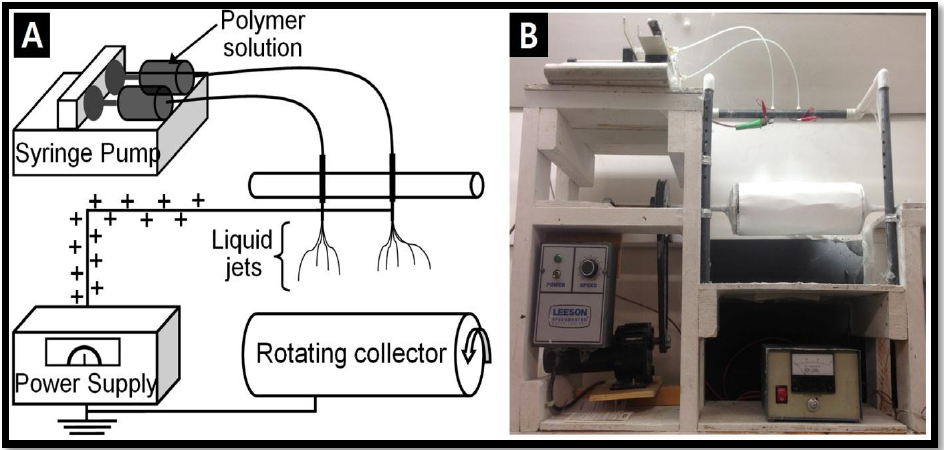
Figure 1. A custom fabricated electrospinning setup with two needles. ( A ) Schematic of electrospinning apparatus and ( B ) Photograph of the laboratory electrospinning setup.